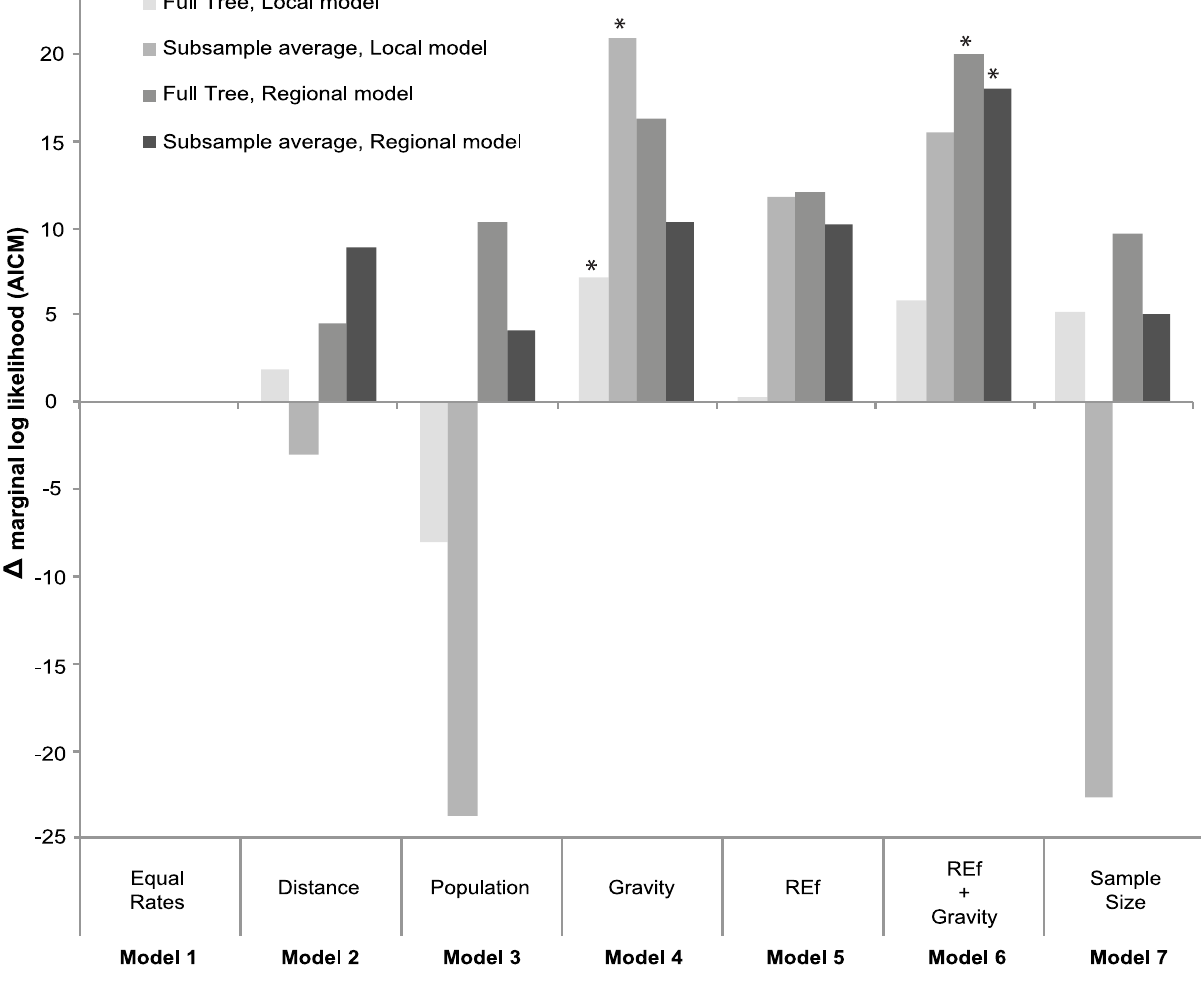
Figure 3. Differences in marginal log likelihood estimates for the fit of different phylogeographic models using AICM. Results show model fittings of Regional and Local phylogeographic model priors for the full DENV-1 genotype 1 data set and for 10 data sets including a maximum of 50 randomly subsampled sequences per location. Models with the best performance for each geographic and sampling scheme are indicated with a star.